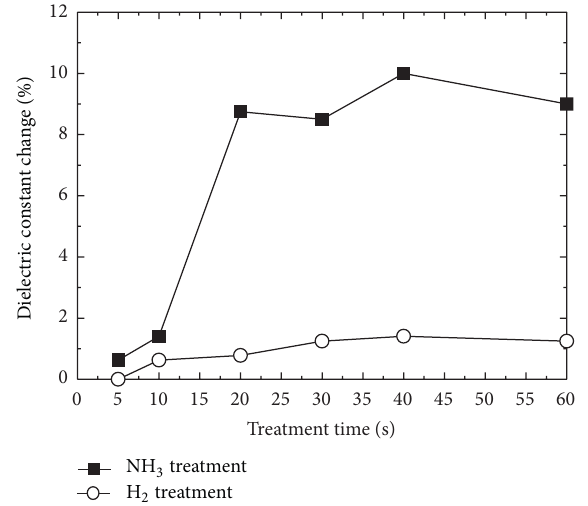
Figure 9: Change of dielectric constant of low- k dielectrics for H 2 and NH 3 plasma treatments as functions of treatment time.